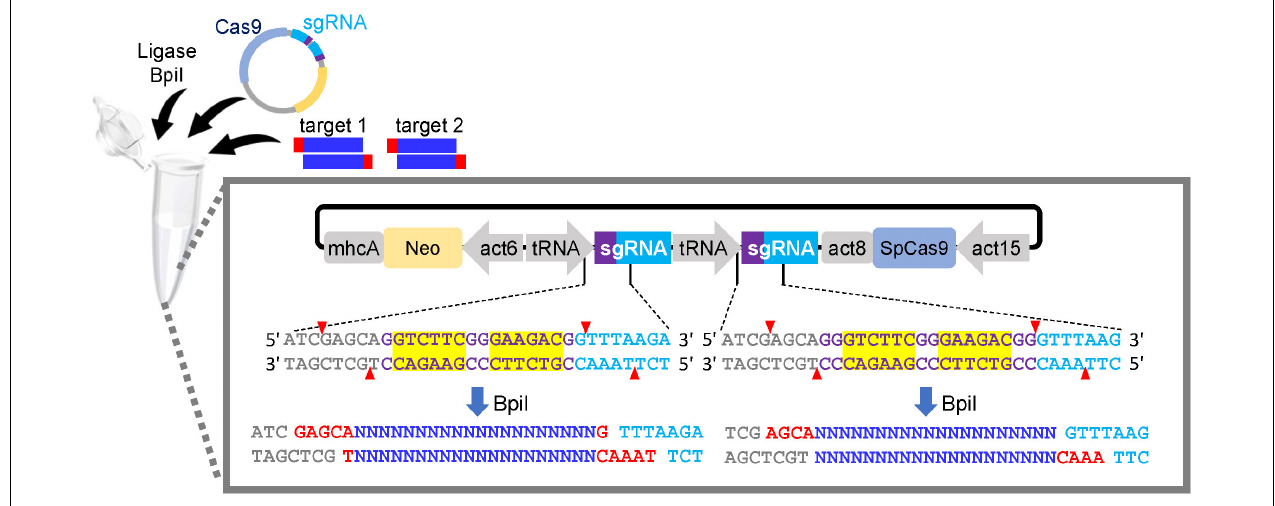
FIGURE 2 | Single cloning step of a dual sgRNA expression vector. Annealed oligonucleotides are ligated to the tRNA–sgRNA junctions via Golden Gate reaction. DNA sequences of BpiI sites are indicated in yellow box. As the BpiI site is non-palindromic, re-digestion/ligation is not possible. Red and blue letters show the overhangs for cloning and target sequences of sgRNAs, respectively. CRISPR vector, T4 DNA ligase and annealed oligonucleotides for the first and second targets are mixed in a single tube to integrate two